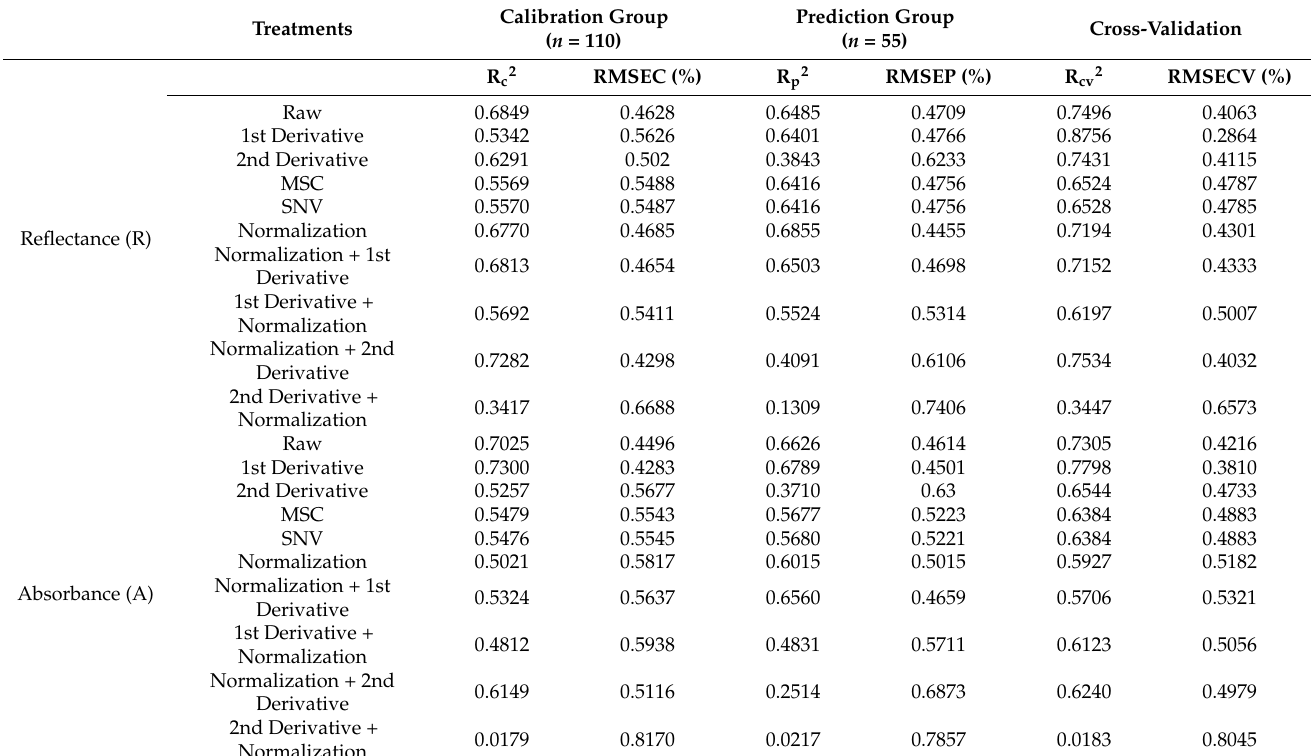
Table 3. Statistical parameters of PLSR with raw and preprocessing spectra based on full wavelengths.